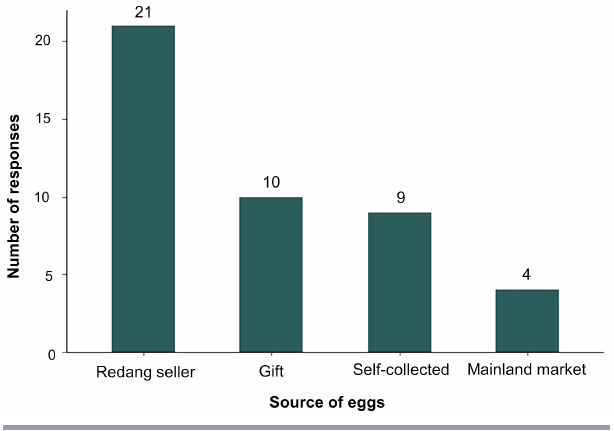
Fig. 3 . Sources of turtle